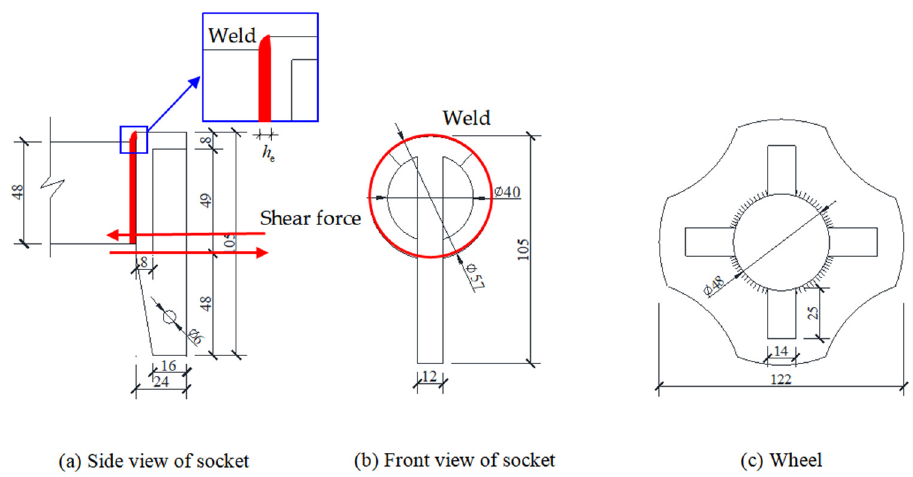
Figure 1. Geometrical size of connection joints.